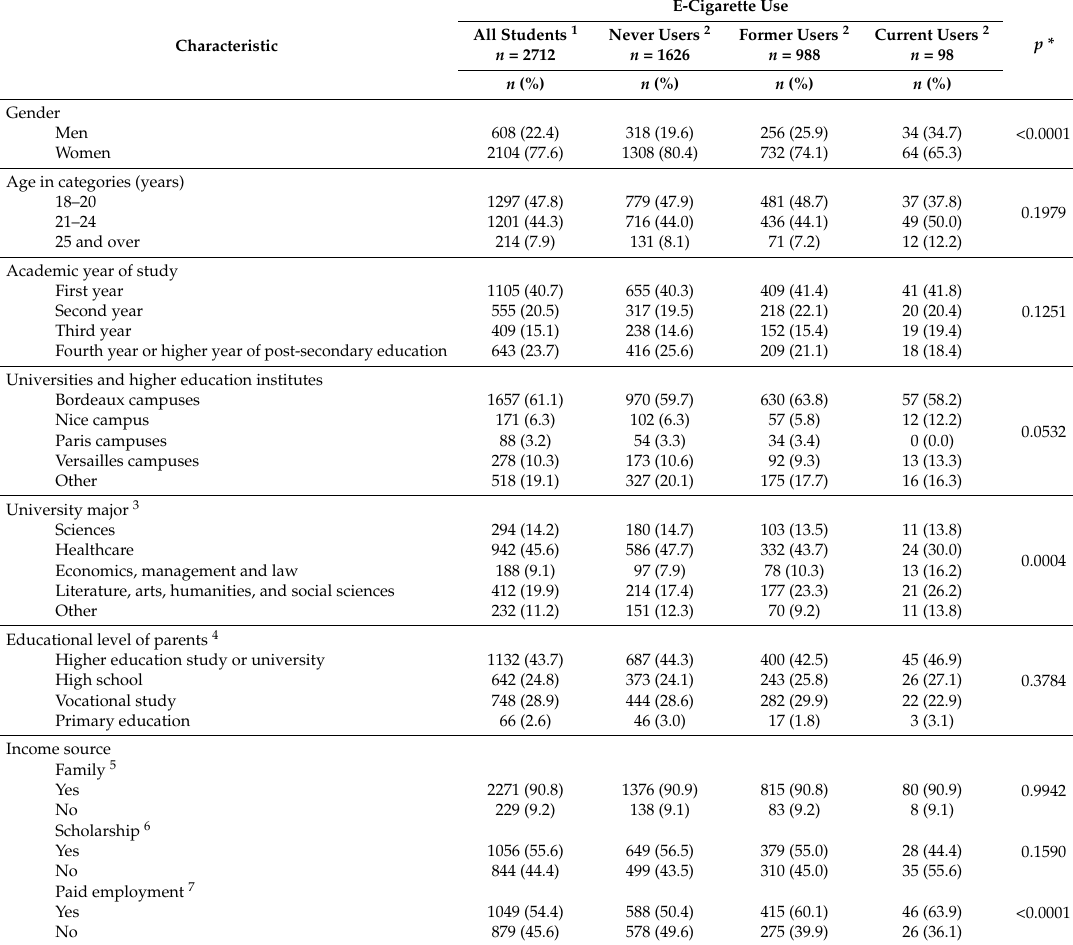
Table 1. Characteristics of study sample according to e-cigarette